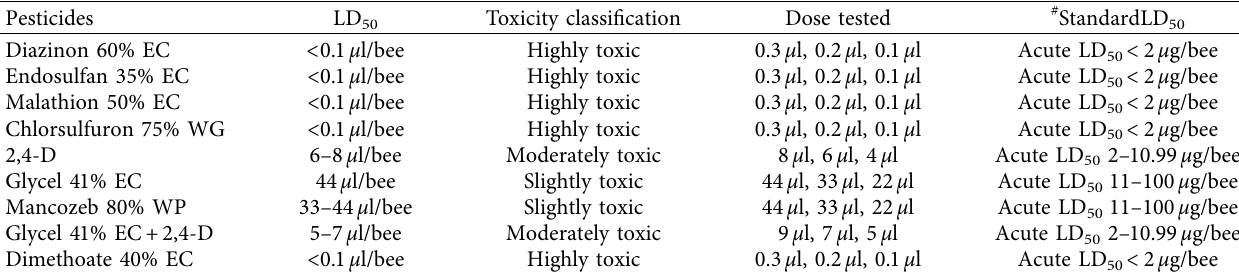
Table 6: LD 50 of pesticides tested in the laboratory and their